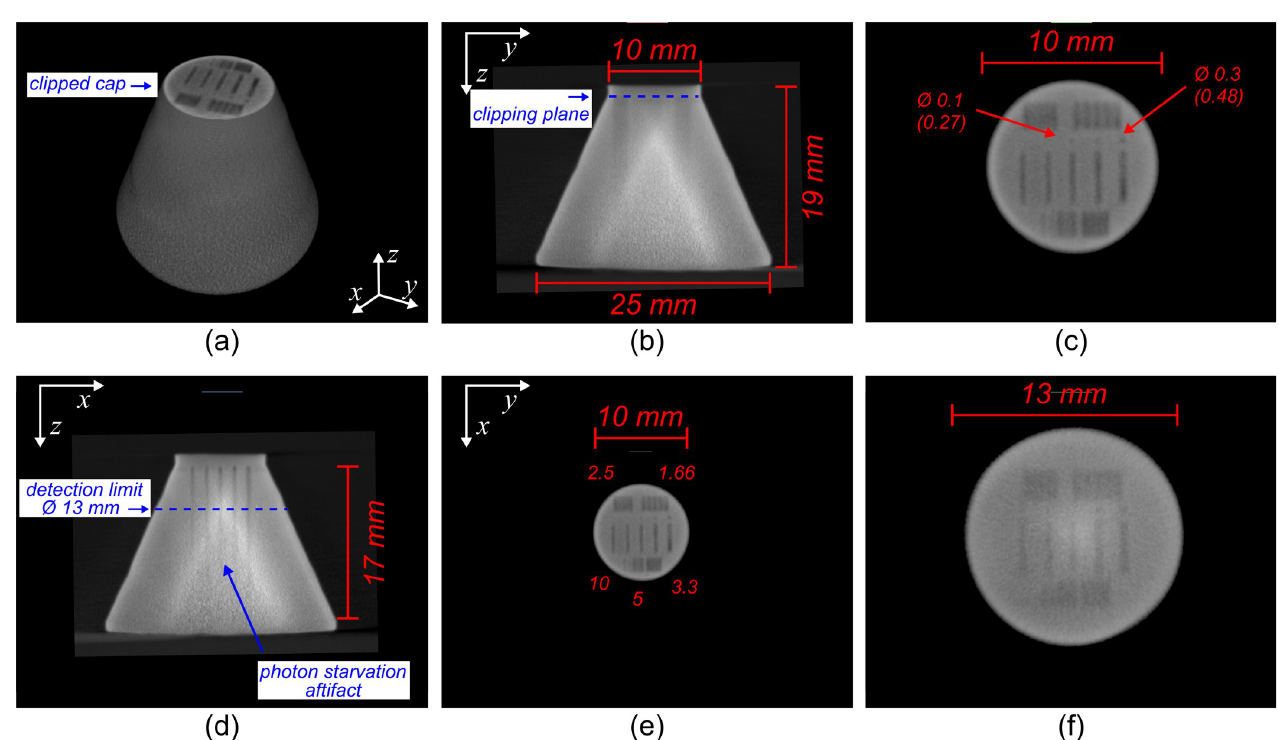
Fig 16. Beam-hardening corrected CT reconstruction of the titanium-alloy resolution phantom using the cost-effective CT scanner. (a) Volumetric rendering of the phantom with the top cap clipped to reveal the internal-void features of the resolution phantom. (b) Transcoronal slice of the resolution phantom showing the relative position of the clipping plane for (a), (c) and (e). (c) Close-up of (e) illustrating the internal features of the phantom at the level of the clipping plane where the outer diameter of the object is 10 mm. Note that the CT-measured true dimensions are labelled in parenthesis after the nominal dimensions of the internal voids. (d) Transsagittal slice of the resolution phantom showing the level where the resolution limit was reached. (e) Transaxial slice of the resolution phantom showing details of the internal features of the phantom at the level of the clipping plane labelled in (b). (f) Transaxial slice at the level of the resolution limit where the external diameter of the phantom was 13 mm. At diameters greater than this, internal-void features are difficult to distinguish and photon starvation artifacts start to dominate.